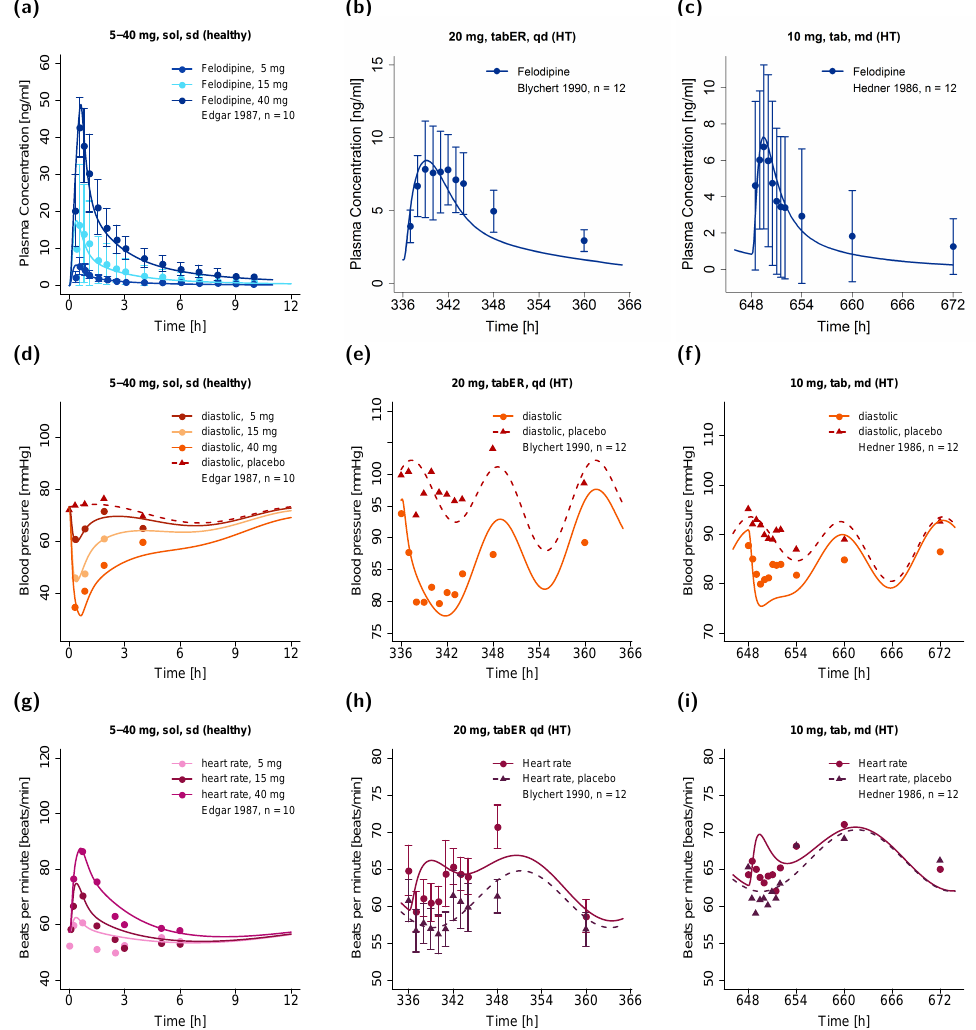
Figure 4. Predicted ( a – c ) plasma concentration–time profiles of felodipine with corresponding pre- 1 dicted ( d – f ) diastolic blood pressure ( g – i ) and heart rate effect–time profiles in healthy individuals (left panel) and hypertensive patients (center and right panels) in comparison to observed data [36,71,74]. Observed data are shown as dots and triangles ± standard deviation (if available); model predictions are shown as lines. HT: hypertensive, md: multiple dose, n: number of individuals, qd: once